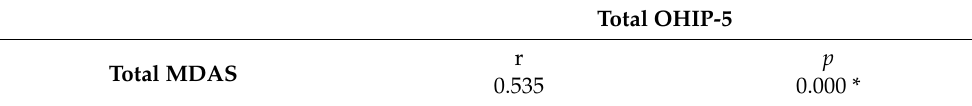
Figure 1. Oral-health-related quality of life by dental anxiety sub-groups. Table 6 revealed a moderate positive correlation between the total MDAS score and total OHIP-5 scale score ( p ˂ 0.001). Table 6. Correlation between elders’ Modified Dental Anxiety Scale (MDAS) score and Oral Health Impact Profile (OHIP-5) scale score.